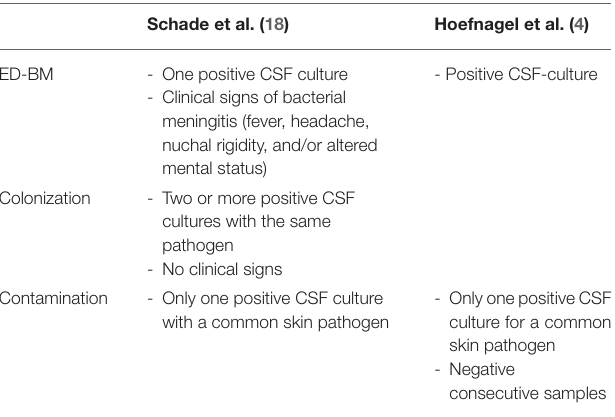
TABLE 1 | Definitions of EVD-associated